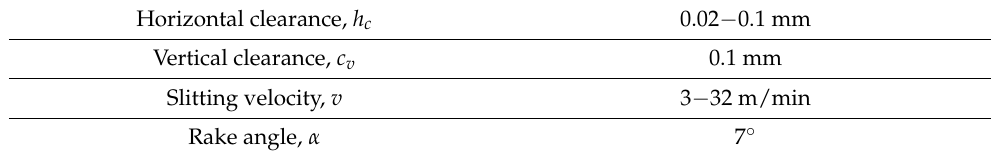
Table 3. The values of the studied